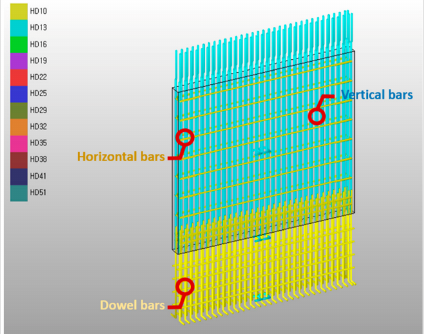
Figure 3. Example of the rebar arrangement of wall members and the name of the rebar for each part (B2F, Building #101 of construction project A).